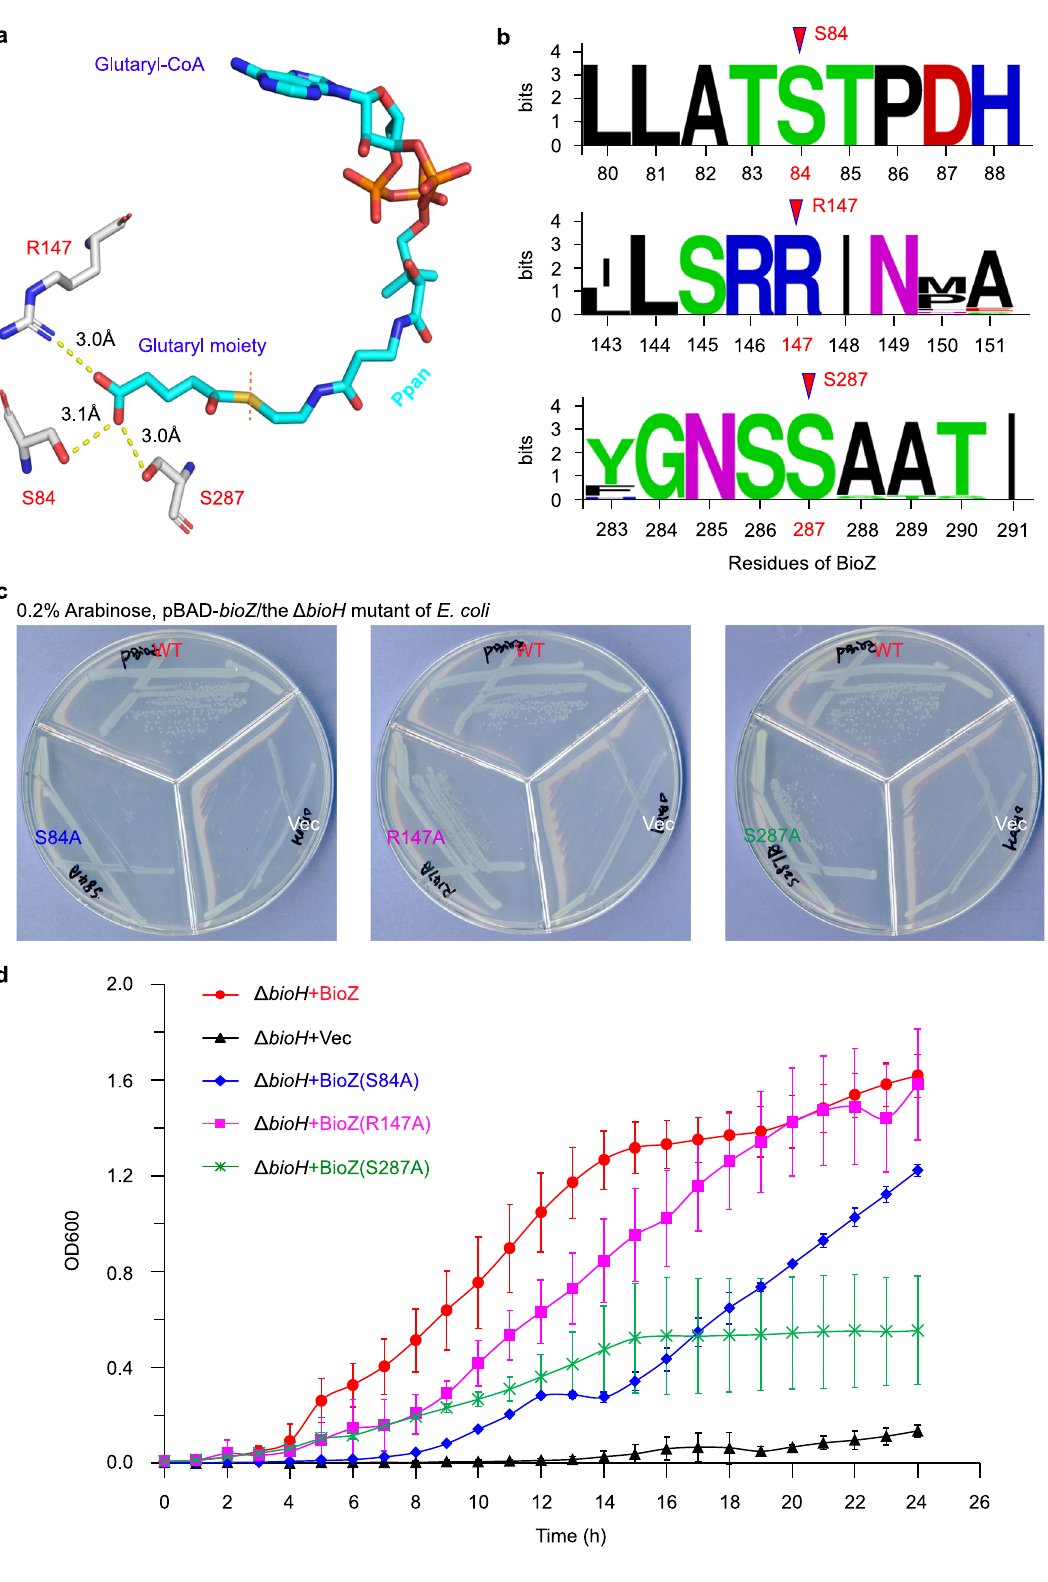
mechanism for bacterial BioZ biotin synthesis. To the best of our knowledge, the BioZ pathway represents a third machinery route for the formation of the biotin precursor pimeloyl-ACP, and poses extensively promising implications in the agricultural, pharma- ceutical, and biomedical fi